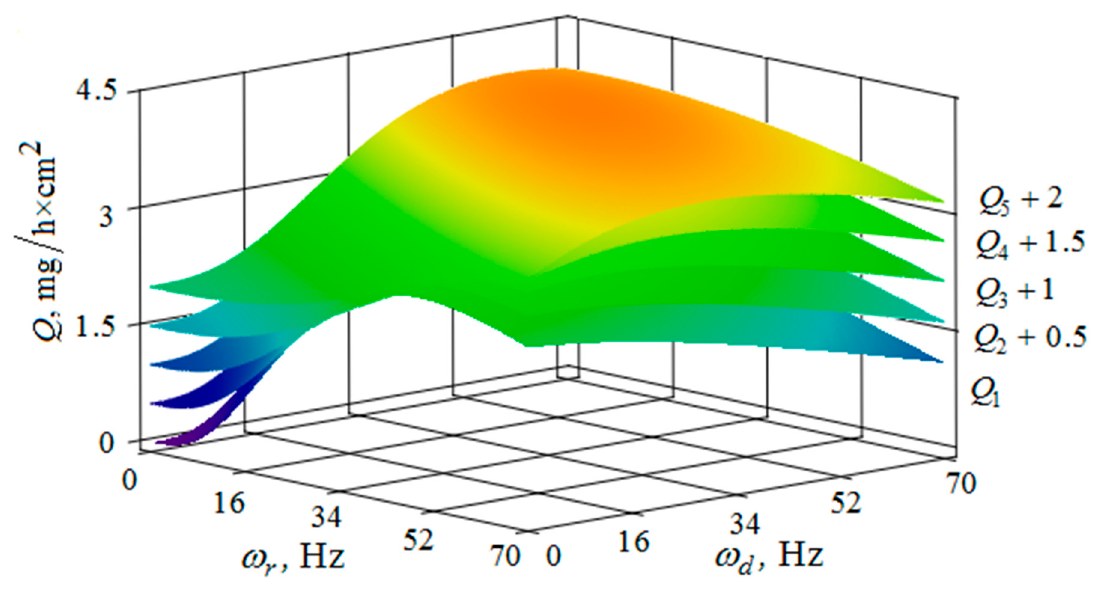
Figure 18. Dependence of the metal removal Q , mg/h·cm 2 on the frequencies of oscillations r ω , Hz and d ω , Hz of the reservoir working surfaces and the processed part for different values of the distance between them: ( 1 Q , 2 Q , 3 Q , 4 Q , 5 Q —metal removal at Y = 40; 80; 120; 160; 200 , mm); the amplitudes of the oscillations of the reservoir surface Ar and the processed part Ad planes are 1 mm.